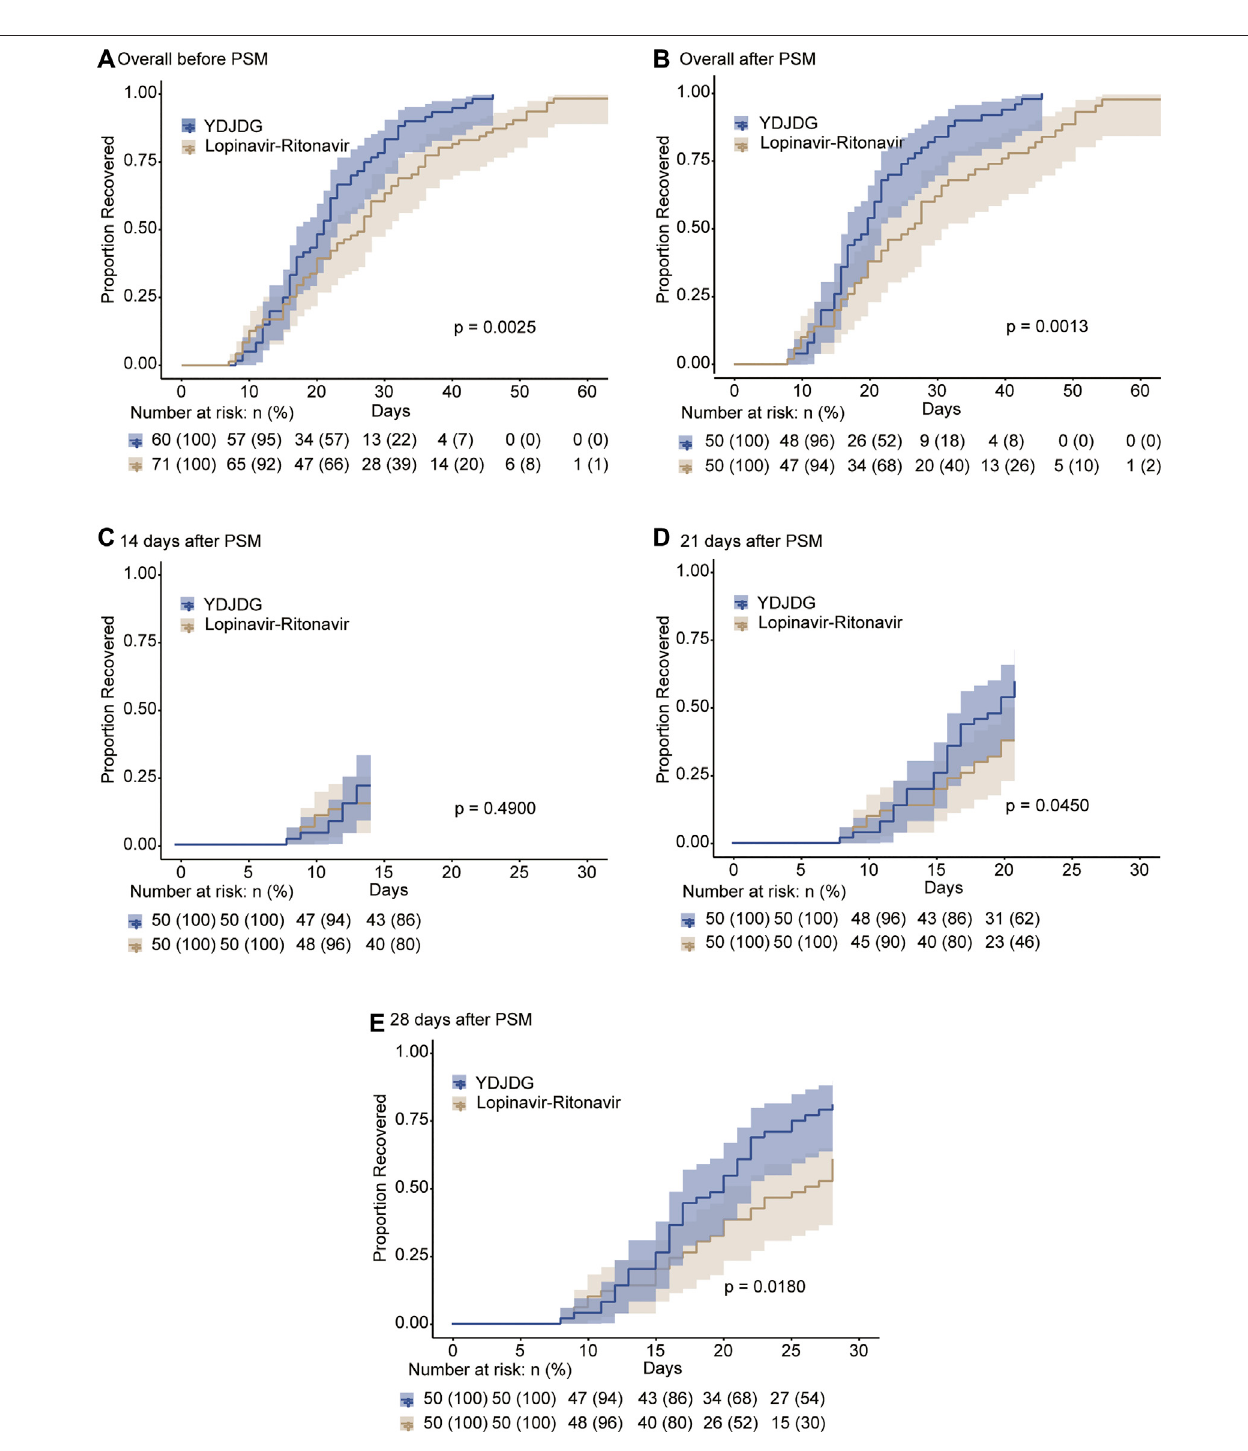
FIGURE4| Kaplan-Meierestimatesofproportionrecovery.ProportionrecoveryestimatesareshowninallpatientsbeforePSM (A) andafterPSM (B) ,afterafollow-upof 14 days (C) , after a follow-up of 21 days (D) , and after a follow-up of 28 days (E) . The median and 95% con fi dence interval (95% CI) are presented in the fi gure.